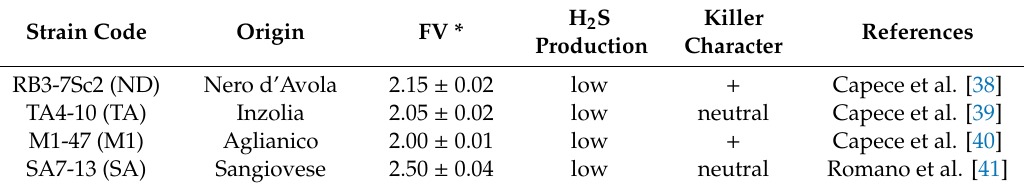
Table 1. Technological characteristics of the four S. cerevisiae strains used in this work. Strain